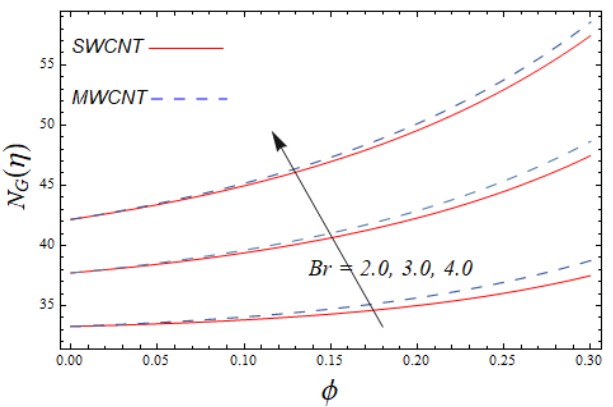
Figure 14. The illustration of B r versus N G (η).